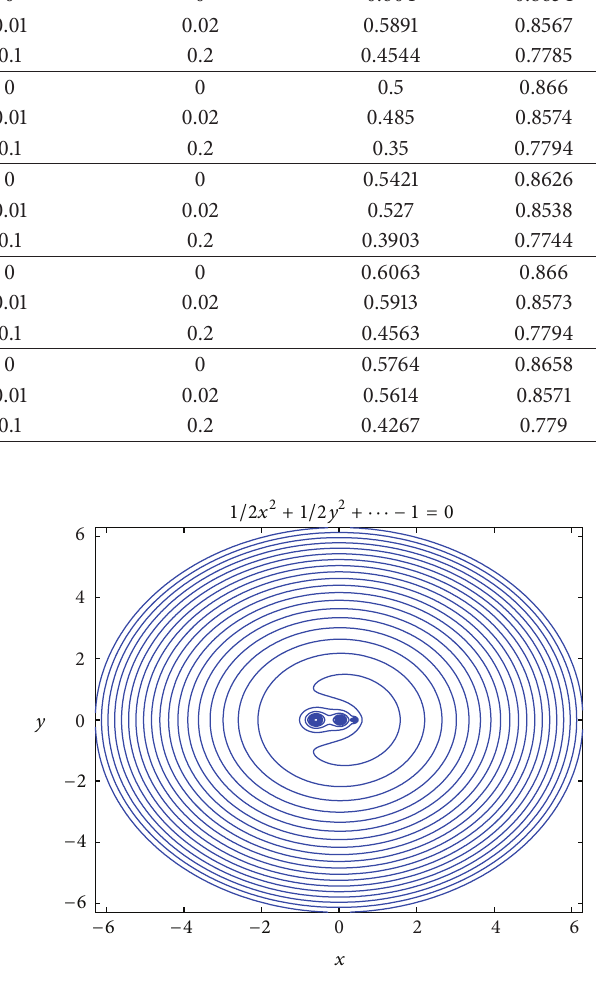
Figure 9: Curve of zero velocity (Luyten-1) 𝑞 1 = 0.9971 , 𝑞 2 = = 0.1 , 𝐴 = 0.2 . 0.9997 , and 𝐴 1 2